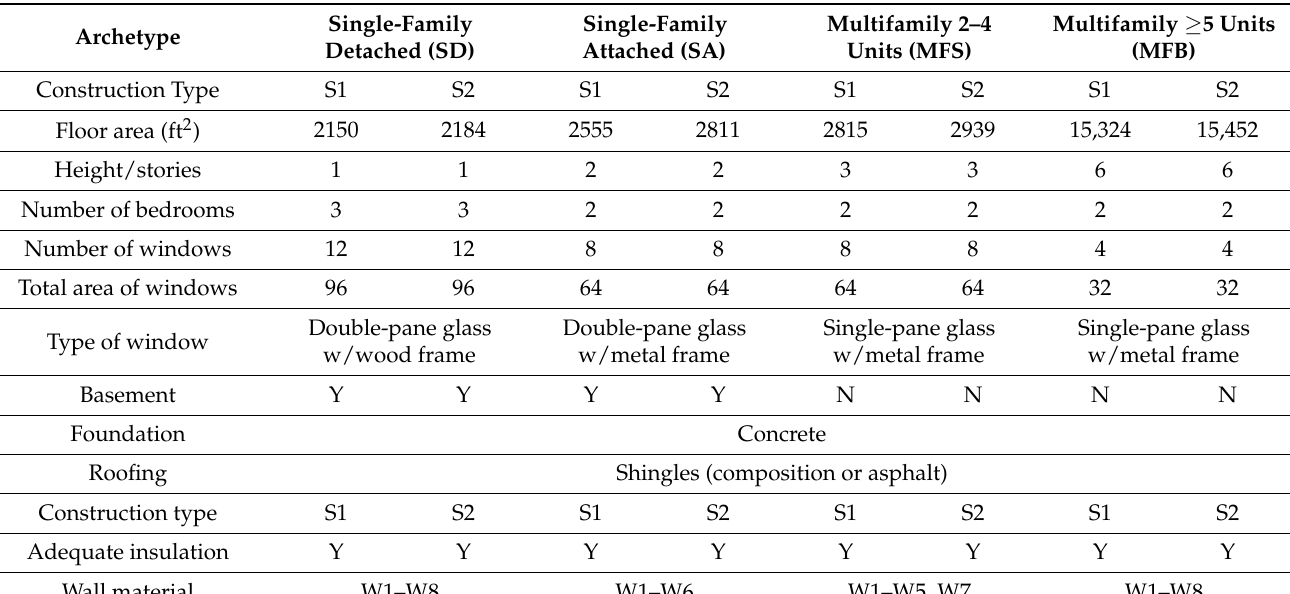
Table 2. Physical characteristics of